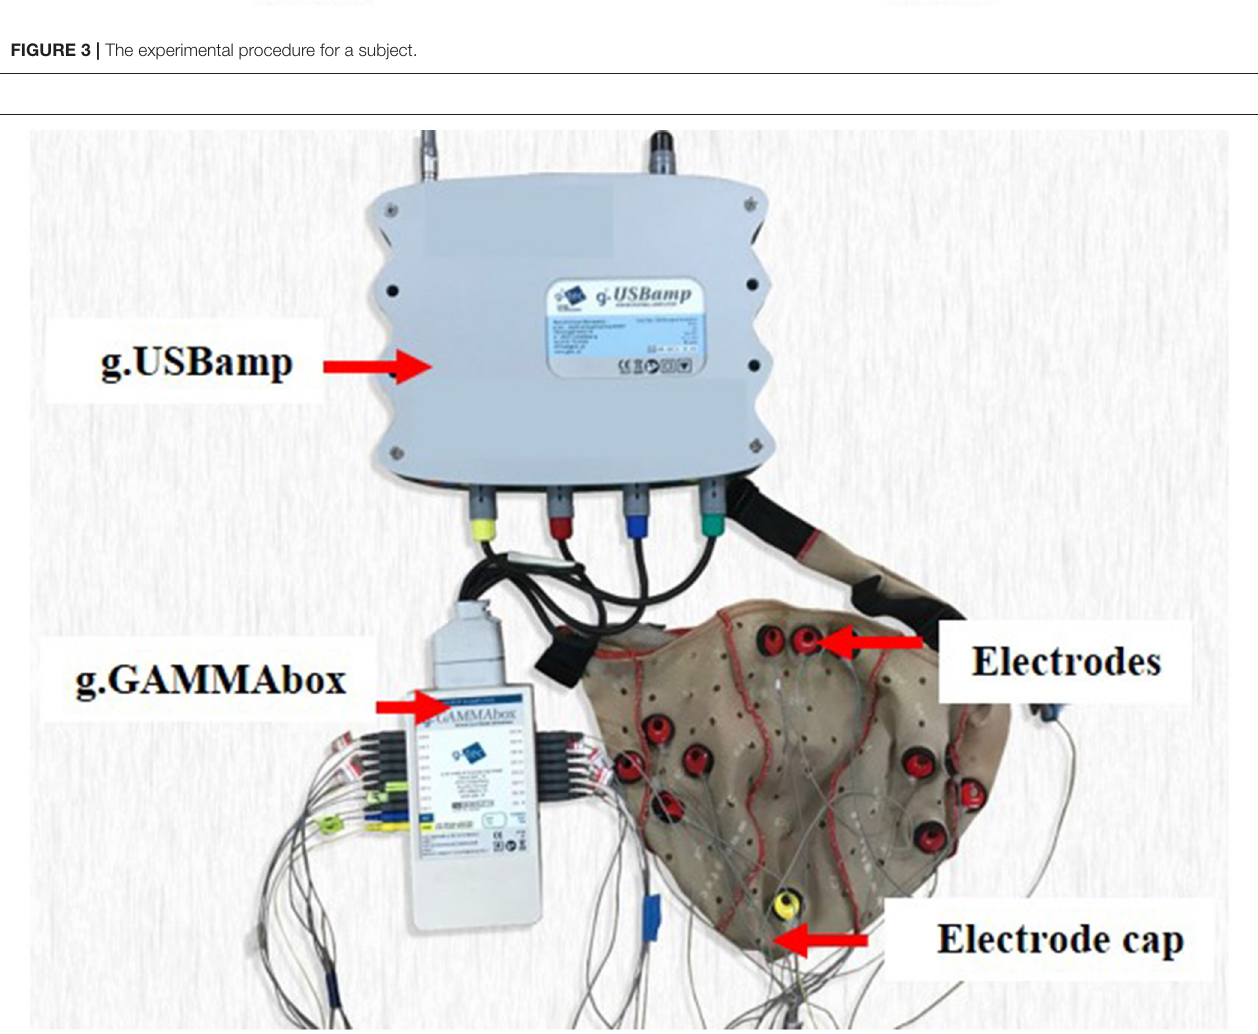
FIGURE 4 | The equipment used to acquire the EEG data.